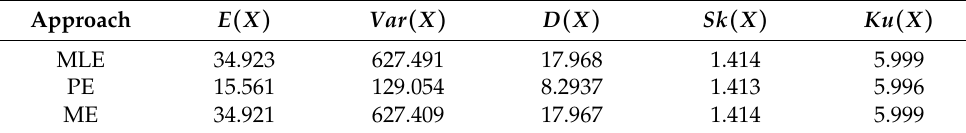
Table 17 . The EDS for COV-P data.